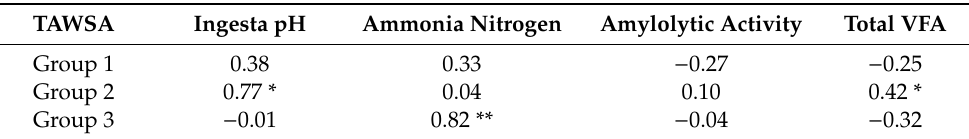
Table 6. Correlation coe ffi cients between the TAWSA (determined in the blood samples) and rumen content (taken 3 h after the beginning of feeding) of rumen-fistulated